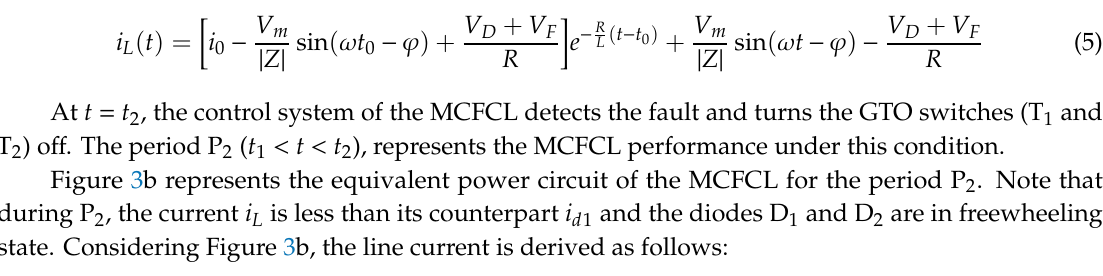
1 , ( b ) P 2 , and P 4 ( c ) P